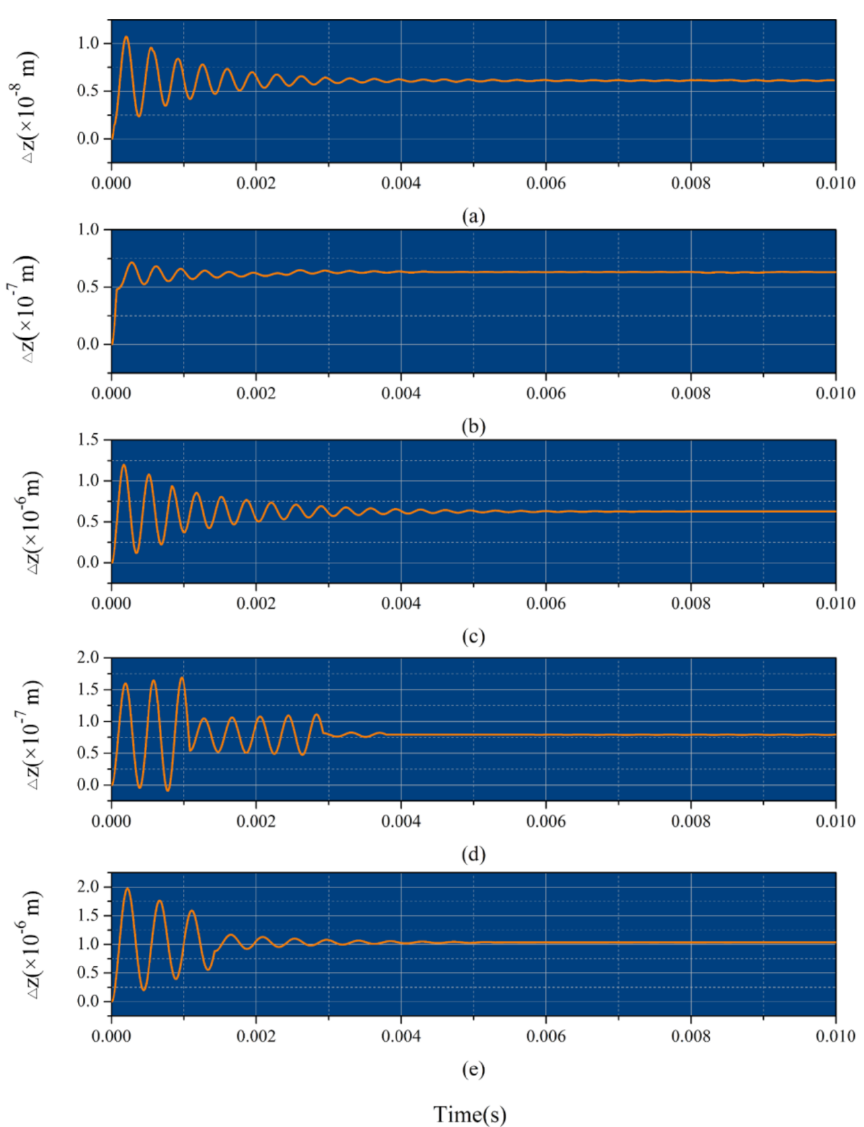
Figure 6. Variations of ∆ z under different external loads and oil supply pressures. ( a ) “5 MPa, 3000 rpm, 1 N ”; ( b ) “5 MPa, 3000 rpm, 10 N ”; ( c ) “5 MPa, 3000 rpm, 100 N ”; ( d ) “3 MPa, 3000 rpm, 10 N ”; ( e ) “3 MPa, 3000 rpm, 100 N